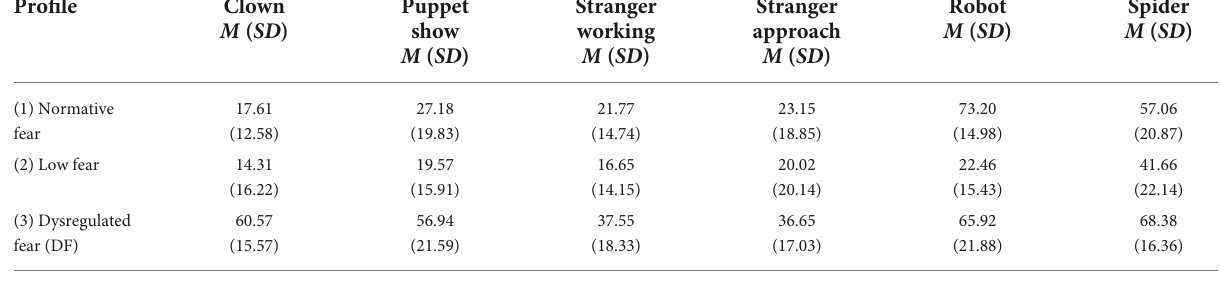
TABLE 4 Means and standard deviations for fear during each Lab-TAB event by profile.